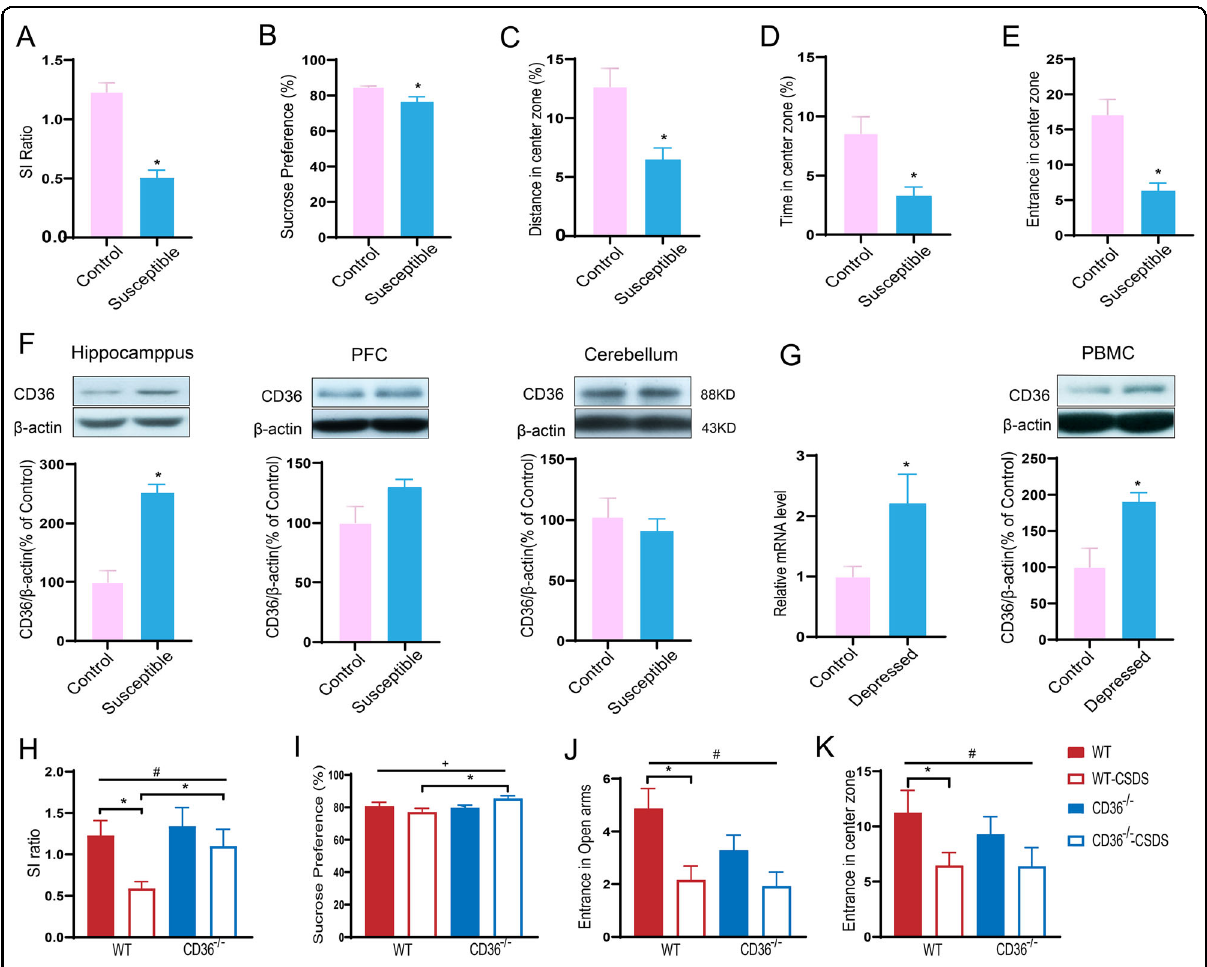
Fig. 1 The relationship between CD36 and depression. Upregulated expression of CD36 in susceptible mice and depressed patients (a – g). a SI ratios for control and CSDS-exposed mice. b CSDS-exposed mice displayed anhedonia as measured by a reduction in sucrose preference ( n = 15 – 17 mice/group, P < 0.05). c – e Open- fi eld test. Compared with control mice, the distance ( c ), proportion of time ( d ), and proportion of entries ( e ) into the center were signi fi cantly decreased in the CSDS-exposed mice. f Representative western blot quanti fi cation of CD36 protein expression in the hippocampus, PFC and cerebellum after CSDS ( n = 5 – 6 mice/group, P < 0.05). g CD36 mRNA level and representative western blotting of PBMCs in depressed patients ( n = 16 mice/group for qPCR; n = 5 – 6 mice/group for western blotting; P < 0.05). Genetic ablation of CD36 in mice prevents chronic social defeat stress-induced depression-like behaviors ( h – k ). h Social interaction (SI) ratios for WT, WT-CSDS, CD36 − / − and CD36 − / − -CSDS mice. CD36 − / − mice showed a signi fi cant increase in social interaction after CSDS. [ # signi fi cant main effect of CSDS : F (1, 46) = 6.419, P < 0.05; * P < 0.05 (post hoc Tukey test)]. i CD36 − / − mice did not exhibit anhedonia, as shown by an increase of 1% in sucrose preference after CSDS. [ + signi fi